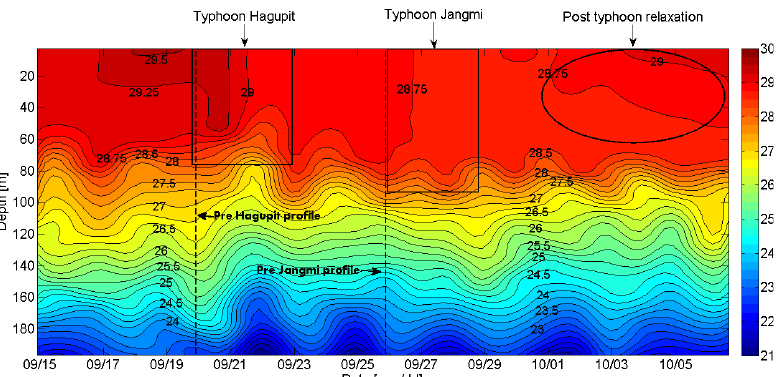
Figure 8. Temperature [ ◦ C] observed by the Argo float ID 5901579. Cooling due to typhoons Hagupit and Jangmi is visible between 20 and 27 September. Fig. 8. Temperature [C] observed by the Argo float ID 5901579. Cooling due to typhoons 3 Hagupit and Jangmi is visible between 20-27 September. 4